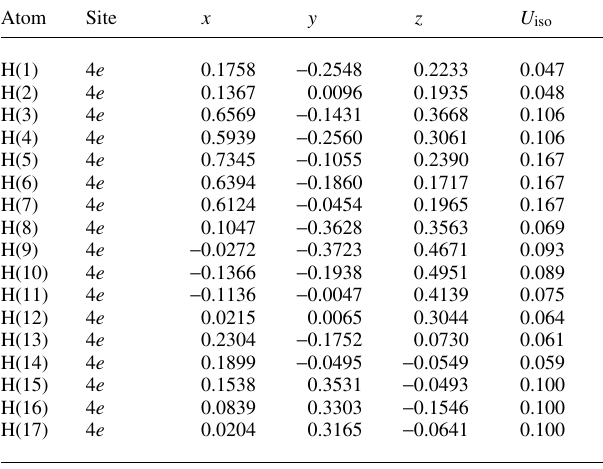
Table 2. Atomic coordinates and displacement parameters (in Å 2 )